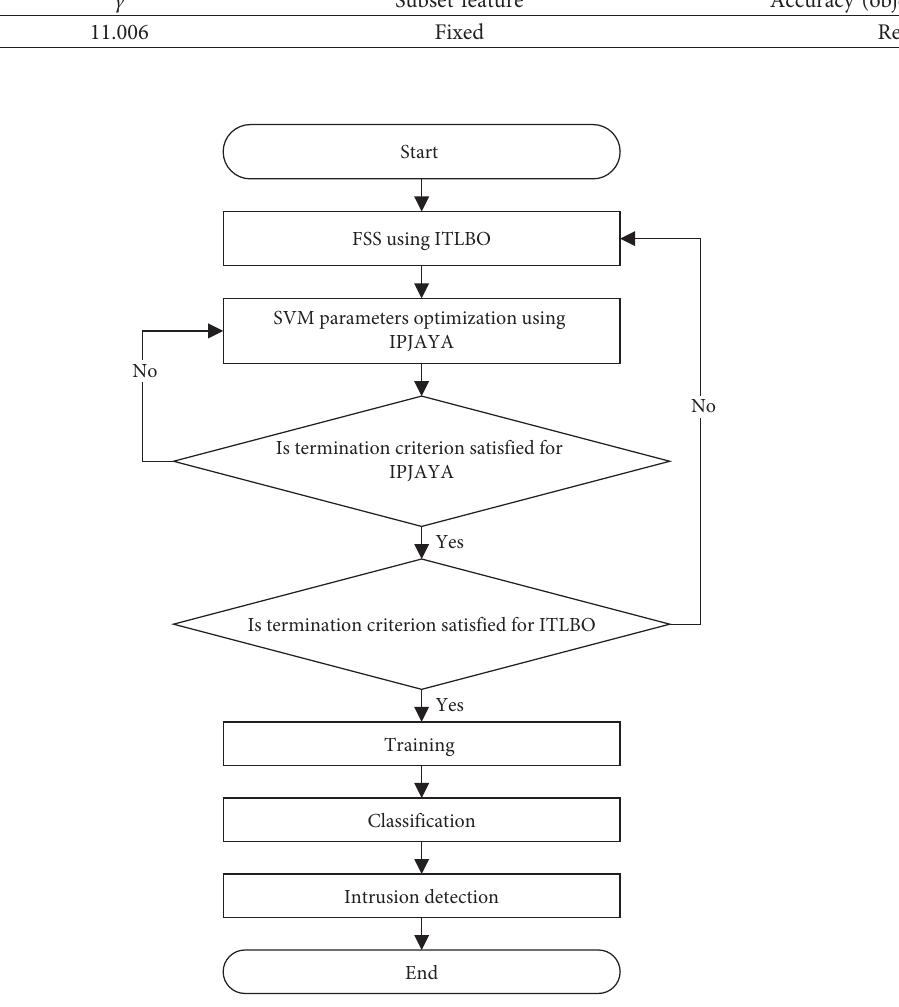
Figure 9: Proposed method